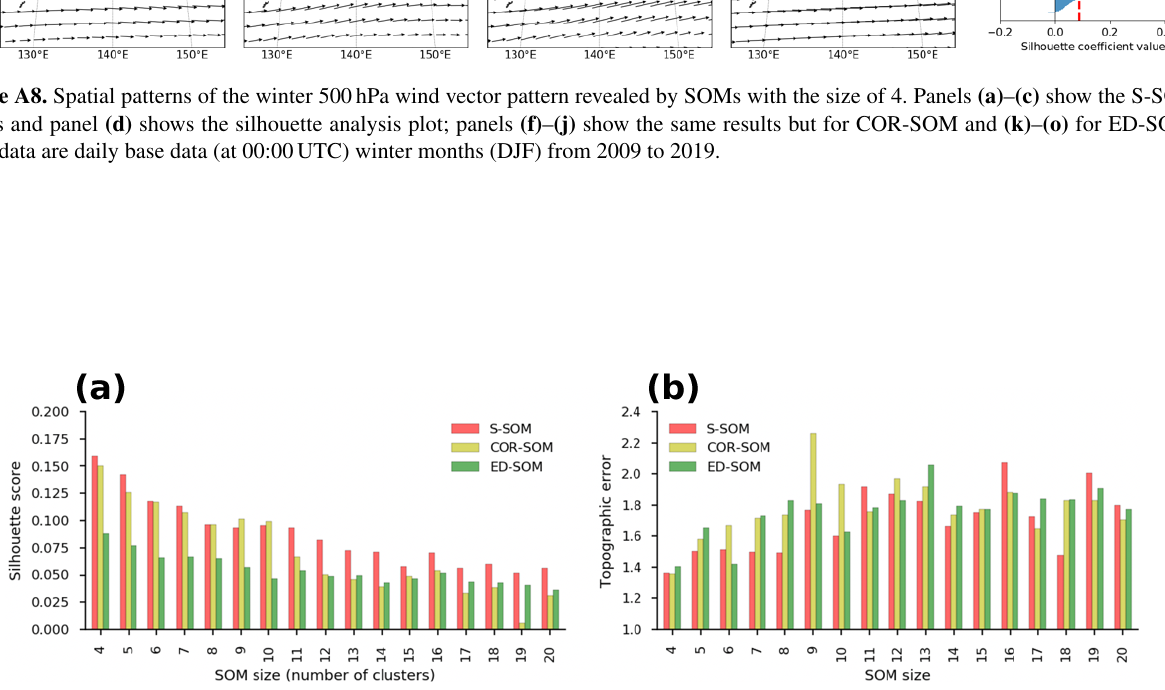
Figure A9. Performance of S-, COR-, and ED-SOM for winter 500hPa wind vector clustering. (a) The silhouette scores; (b) topographic errors of SOMs at different node